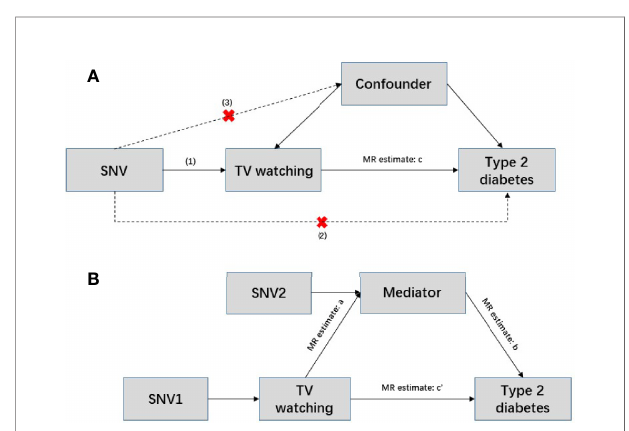
FIGURE 1 | Conceptual diagram of Mendelian randomization and mediation analysis. (A) Mendelian randomization is based on the following three assumptions. (1) Genetic variants are strongly associated with exposure (p<5×10 -8 ); (2) instrumental variables can only act on the outcome through exposure, and there is no direct association with the outcome; and (3) instrumental variables are independent of any confounding factors. In this situation, c represents the total effect, SNV: single nucleotide variant. (B) Two-step Mendelian randomization, where a represents the effect of the exposure on the mediator; b represents the effect of mediator on the outcome; c ’ represents the direct effect; and a and b are estimated separately using separate genetic instrumental variables for both the exposure and mediator. These estimates are then multiplied together to estimate the indirect effect of the mediator (a * b), and the direct effect c ’ = c –